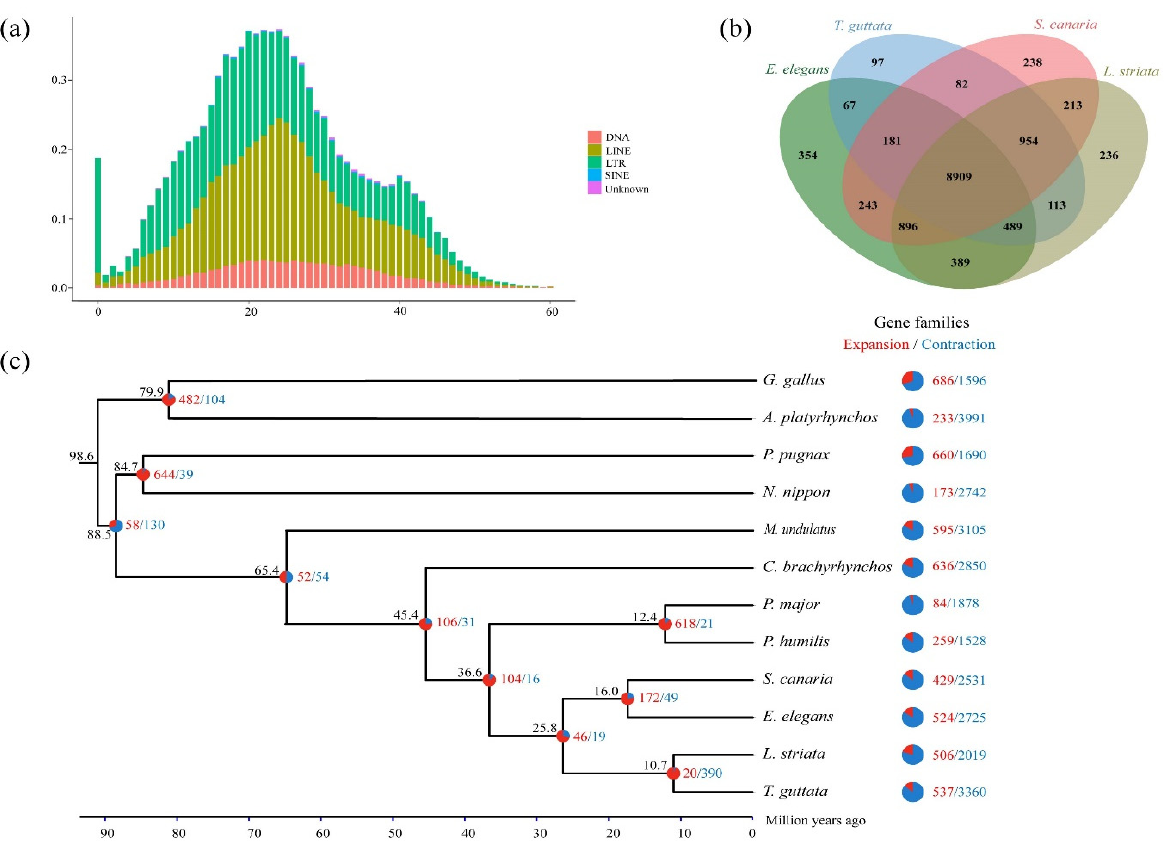
Figure 2. Comparative genomics in avian species studied: ( a ) divergence rate of transposable elements. The x-axis represents the divergence rate of annotated transposable elements, while the y-axis represents the genomic percentage of the corresponding transposable elements; ( b ) Venn diagram showing the number of orthogroups identified within the four Passeriformes species: E. elegans (green), T. guttata (blue), S. canaria (pink), and L. striata (brown); ( c ) phylogenetic relationships and divergence times between the 12 avian species estimated from MCMCtree. The numbers to the left of each node indicate divergence time. The expansion and contraction of gene families in these 12 species are shown in different colors, where red represents expanded gene families, and blue represents contracted gene